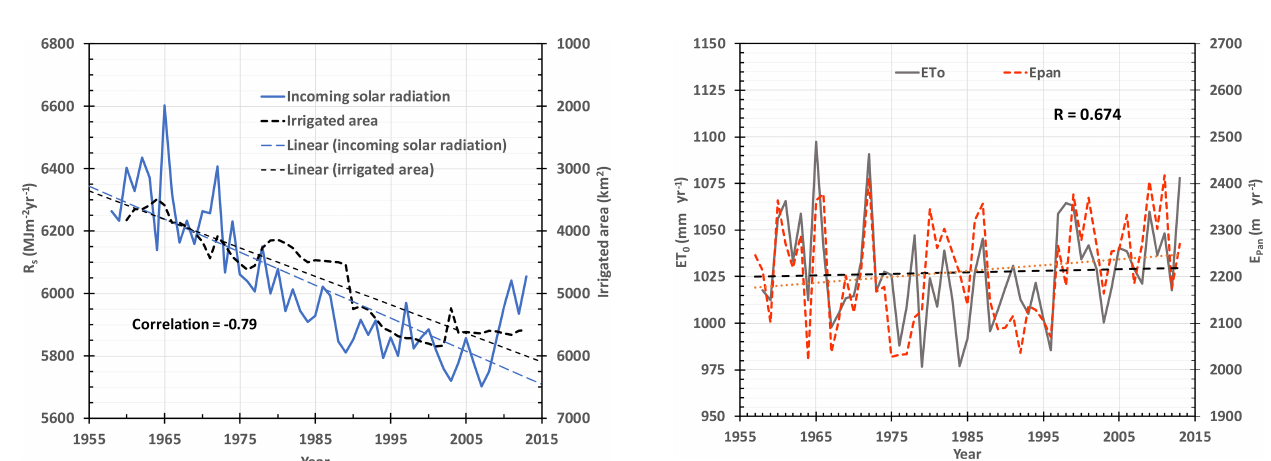
Figure 7. Estimated temporal change of incoming solar radiation to Hetao from 1958 to 2013 using Eq. (2). Also shown is the change in area of land irrigated (plotted in reverse order) and significant linear trends.